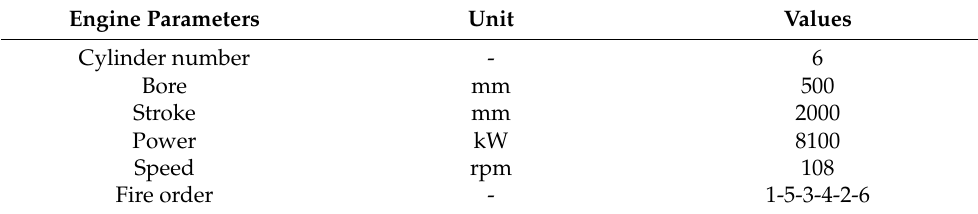
Table 1. Specification of the dual-fuel engine.